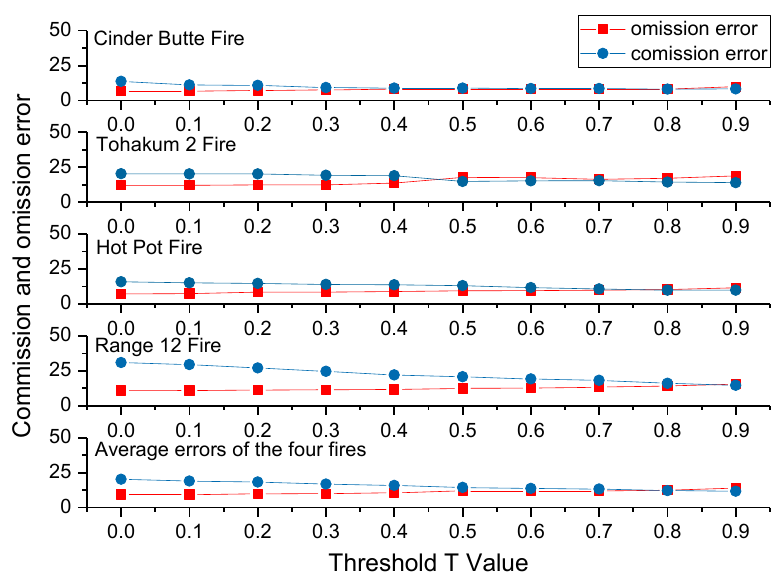
Figure 10. Change trends of commission error and omission error along with the thresholds of [0, 0.9] range in the wildfire cases using the proposed method.